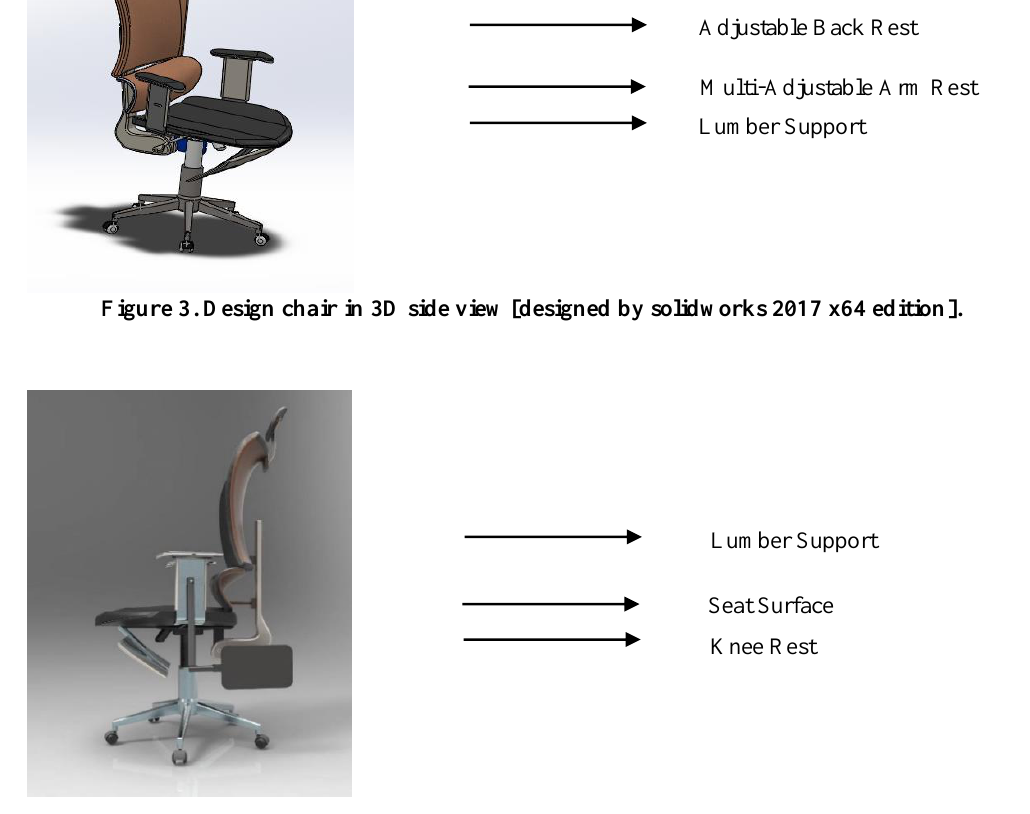
Figure 4. Design chair with different features in 3D side view [designed by solidworks 2017 x64 edition and rendered by luxion keyshot pro v5.0.86